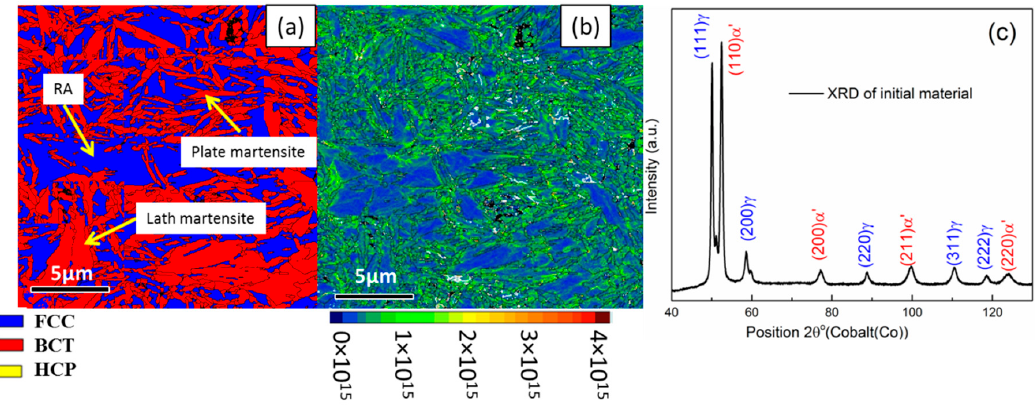
Figure 1. EBSD micrograph and XRD spectrum of the material before compression test. ( a ) Phase map, here red is martensite and blue is RA; ( b ) dislocation mapping. Black lines are grain boundaries with a misorientation angle of more than 15°; ( c ) XRD showing RA and martensite peaks.